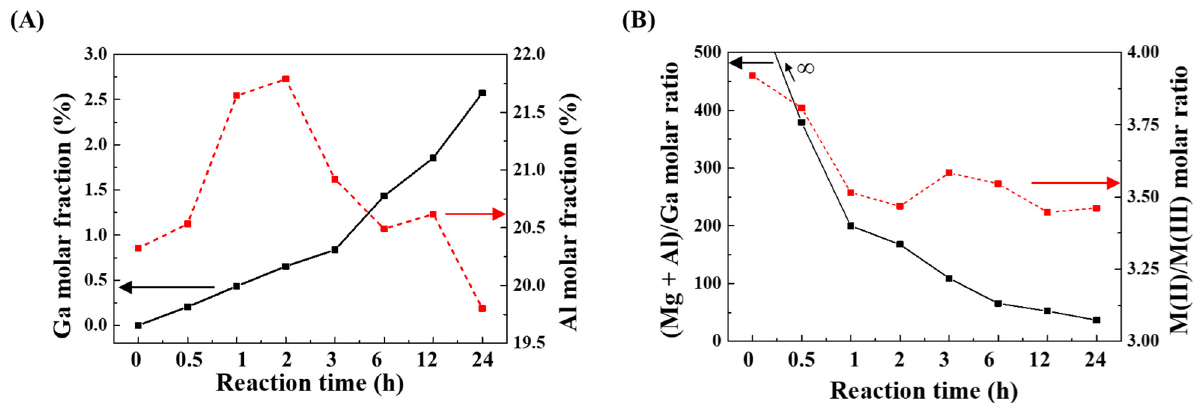
Figure 1. Quantitative result of ( A ) time-dependent molar fraction of Ga (black solid line, left y -axis) and Al (red dotted line, right y -axis) in Ga@LDHs. ( B ) Time-dependent (Mg + Al)/Ga ratio (black solid line, left y -axis) and M(II)/M(III) ratio (red dotted line) in Ga@LDHs by inductively coupled plasma-mass spectrometer (ICP-MS).